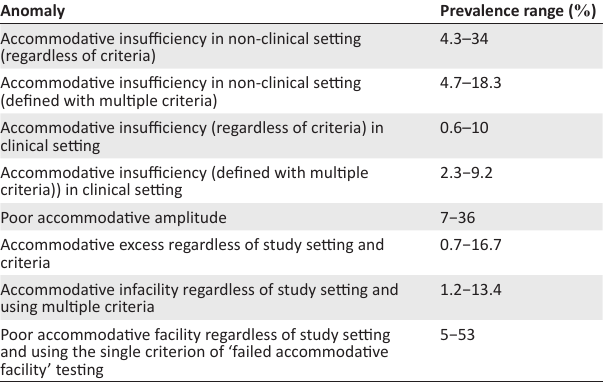
TABLE 5: Summary of range of prevalence for all accommodative anomalies.